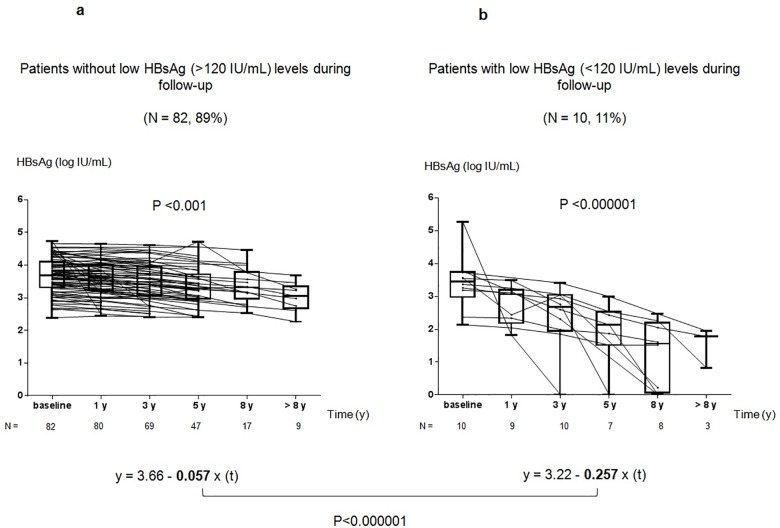
A and B. Different kinetics of qHBsAg in HBeAg-negative CHB patients receiving NAs. Fig 1A shows the kinetics of qHBsAg (log IU/mL) in patients who did not achieve low levels (>120 IU/mL) during follow-up (n = 82). Fig 1B shows the kinetics of qHBsAg in patients who achieved low levels (<120 IU/mL) during follow-up (n = 10). Using a mathematical mixed model for repeated measurements, the slope in patients who achieved low levels of HBsAg (y = 3.22–0.257x(t)) was significantly greater compared to those who did not (y = 3.66–0.057x(t)) (p <0.001).